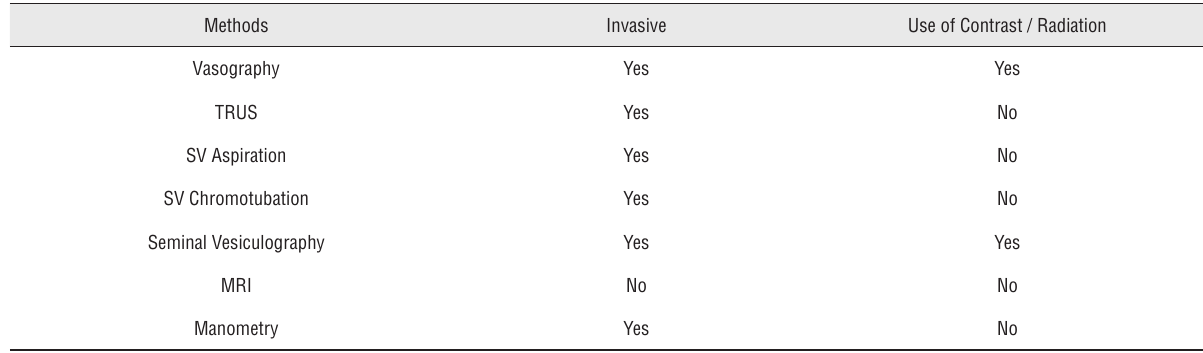
Table 1 - Characteristics of diagnostic methods for ejaculatory duct